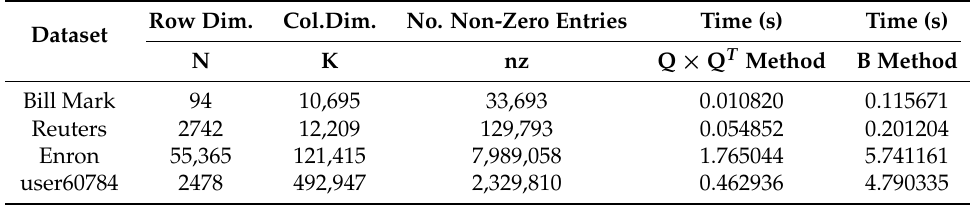
Table 1. Timings for dimensional reduction